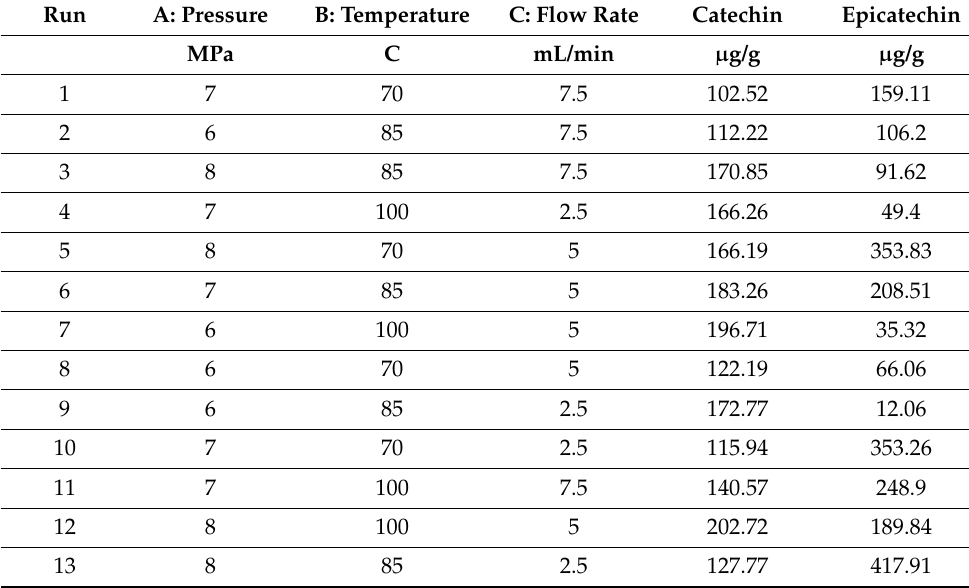
Figure 1. The subcritical methanol extraction (SME) scheme. Table 1. The parameters and responses of subcritical methanol extraction.